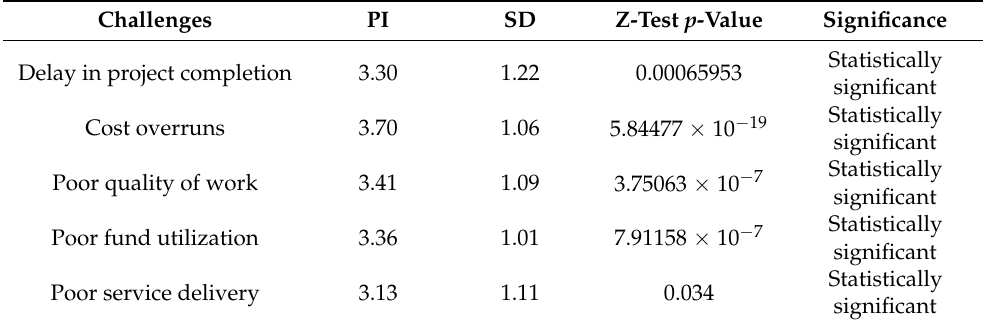
Table 3. Challenges of project delivery.